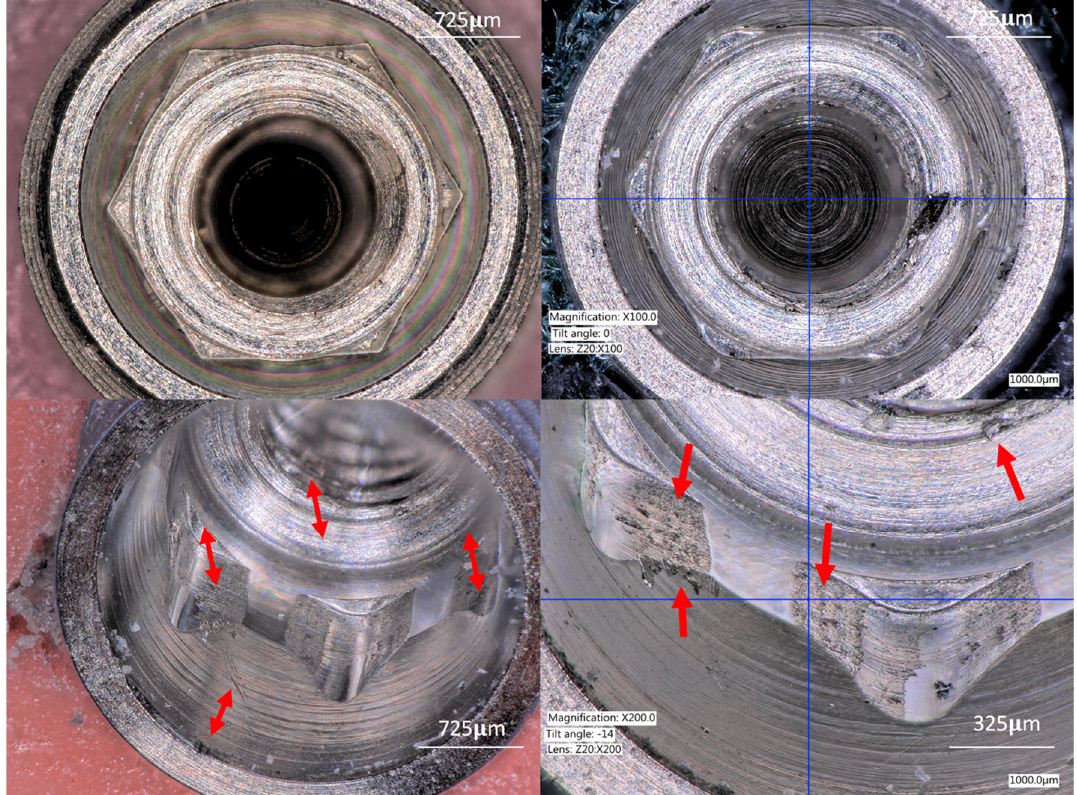
Figure 2. Upper left image shows a coronal view of Group A (Internal hexagon) Upper right image shows a coronal view of the same group with some scratches and widening of the vertex angles. Lower left image shows scratches at the internal cone and areas of deformation indicated by the red arrows. Lower right image is showing surface damage and titanium particles at the edges of the connection walls released during the implant insertion.